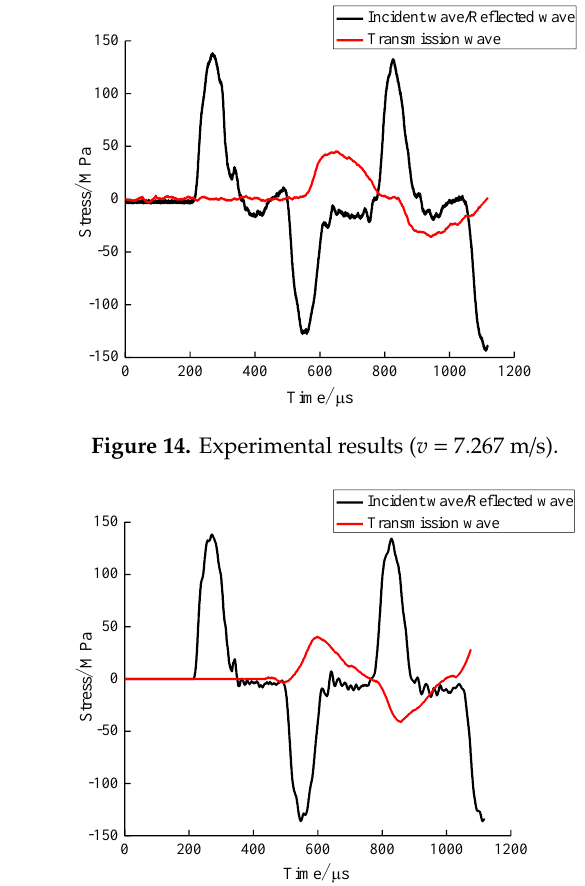
Figure 15. Simulation results ( v = 7.267 m/s).